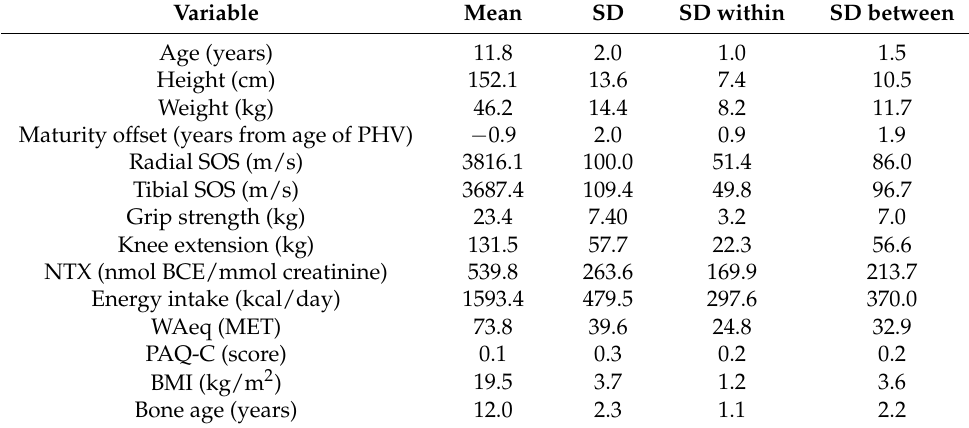
Table 1. Summary statistics (means and standard deviations) of all variables used in the analysis, within and between participants.